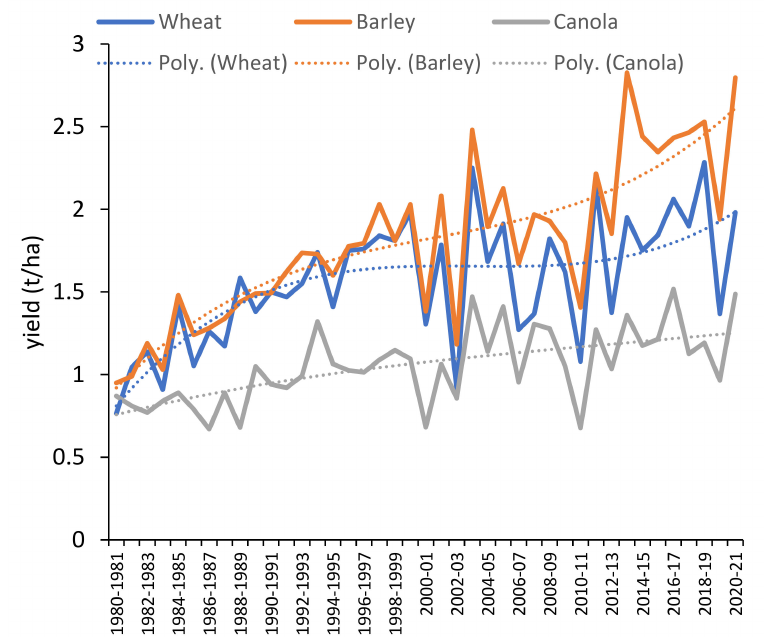
Figure 4. Wheat, barley and canola yields in south-western Australia: 1980 to